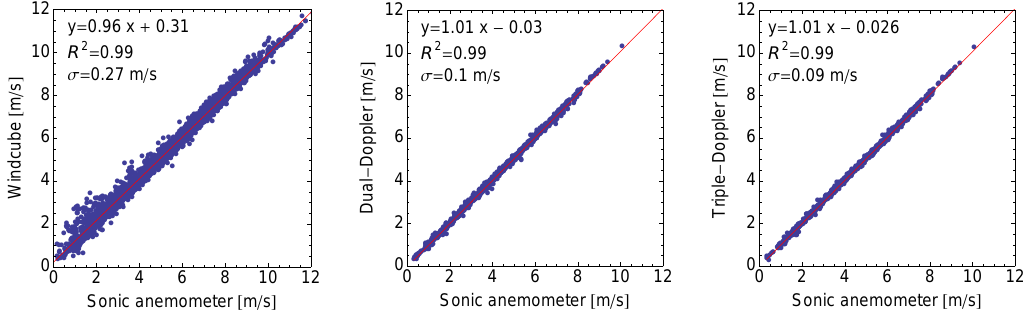
Figure 10. The horizontal wind speed retrieved in complex terrain by the long-range WindScanner system operated in a triple- and dual-Doppler mode and Windcube V2, in comparison to the horizontal wind speed acquired by a sonic anemometer. The results are given as 10-min